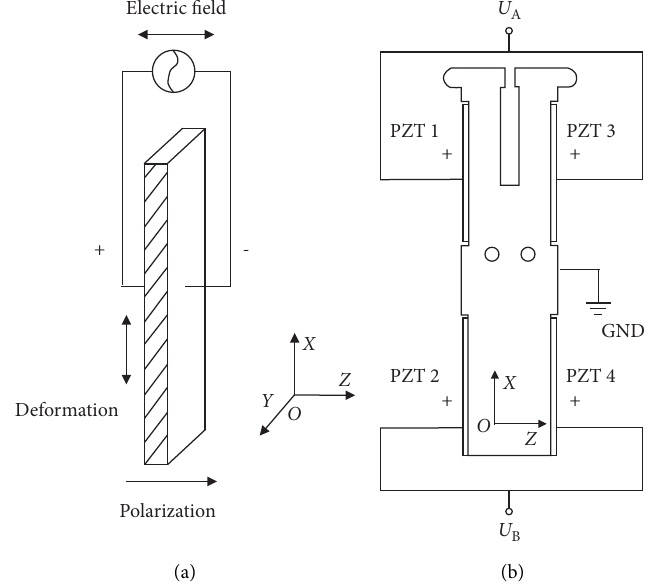
Figure 3: Exciting mode of the stator. (a) Polarization direction of piezoceramics. (b) The voltage exciting mode.